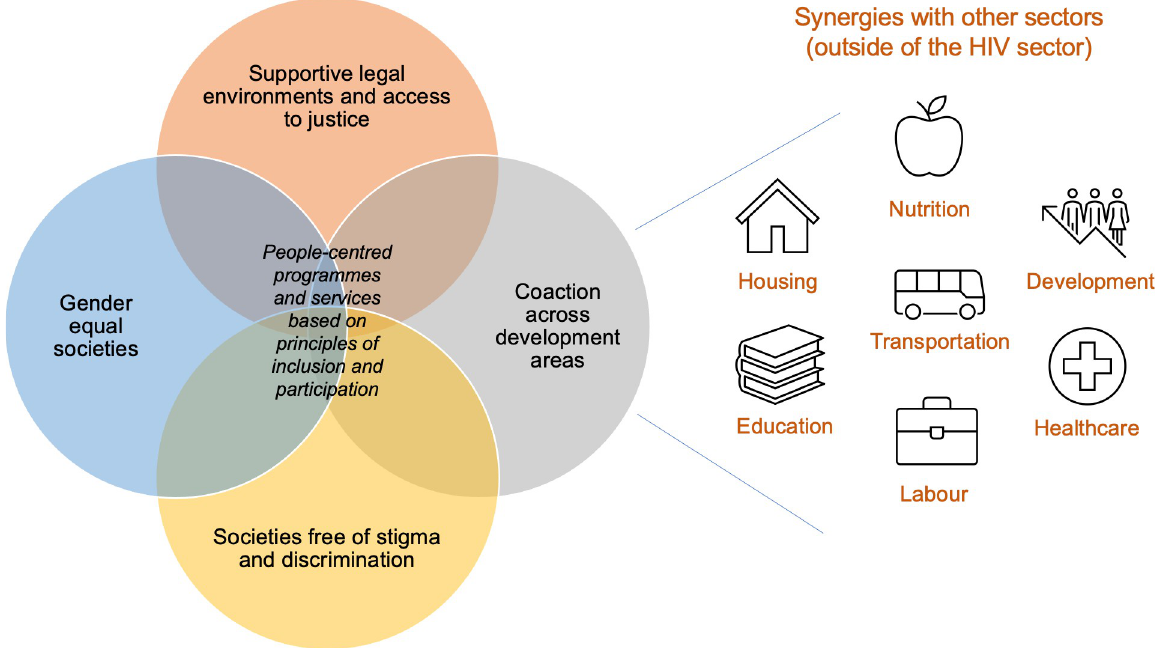
Fig 1. The societal enablers of the HIV